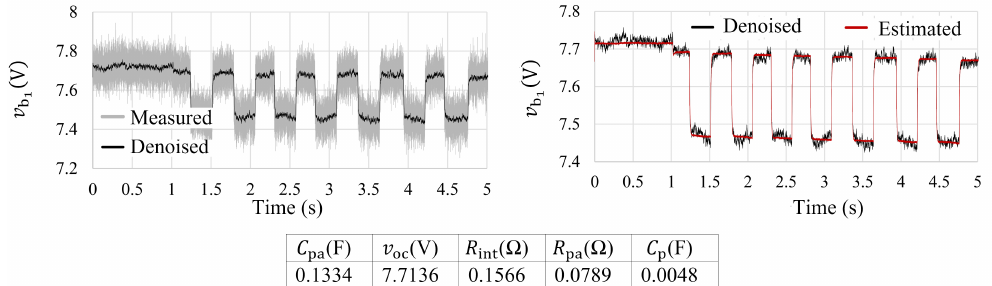
Figure 13. Scenario three: measured, filtered, and estimated output voltage of the first module ( v b